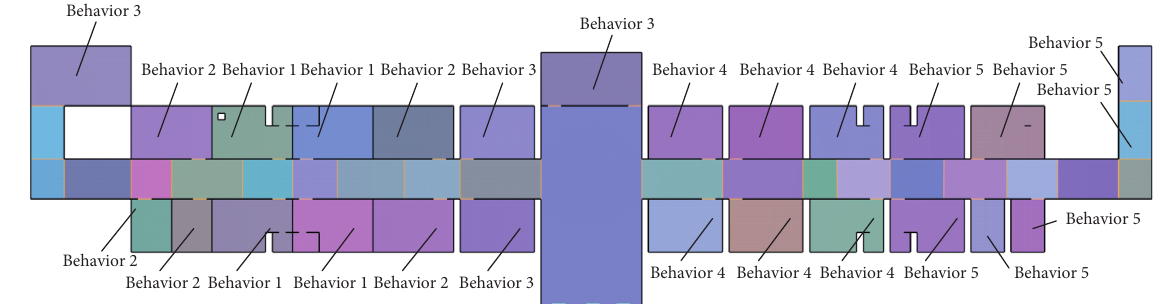
Figure 8: Different